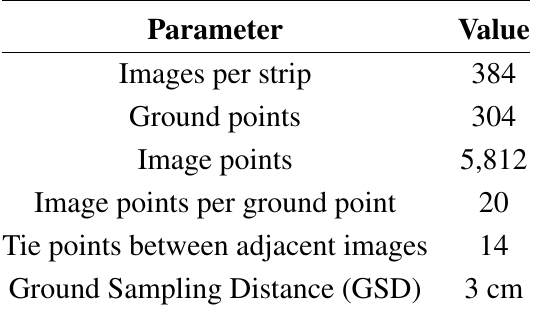
Table 3. Simulation results.